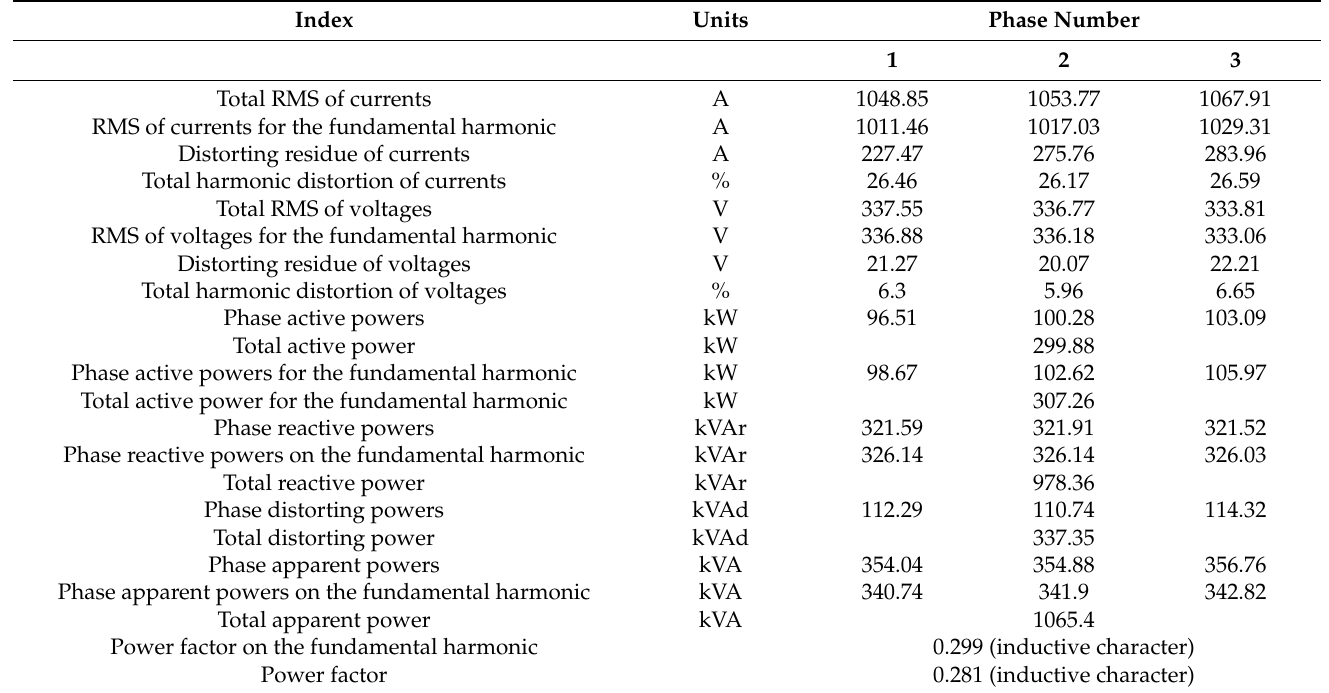
Figure 5. Harmonic spectra of active powers ( top ) and reactive powers ( bottom ) for the secondary winding of the transformer for excitation supply (harmonic weights > 1.2%). Table 1. Power quality indices, powers and power factors are computed with FFT and the first theory, Various PQ indices and powers were computed using the mathematical formulations the first case from the previous Section 2.1.1 and the results of numerical harmonic decompositions. The numerical results are gathered in Table 1.